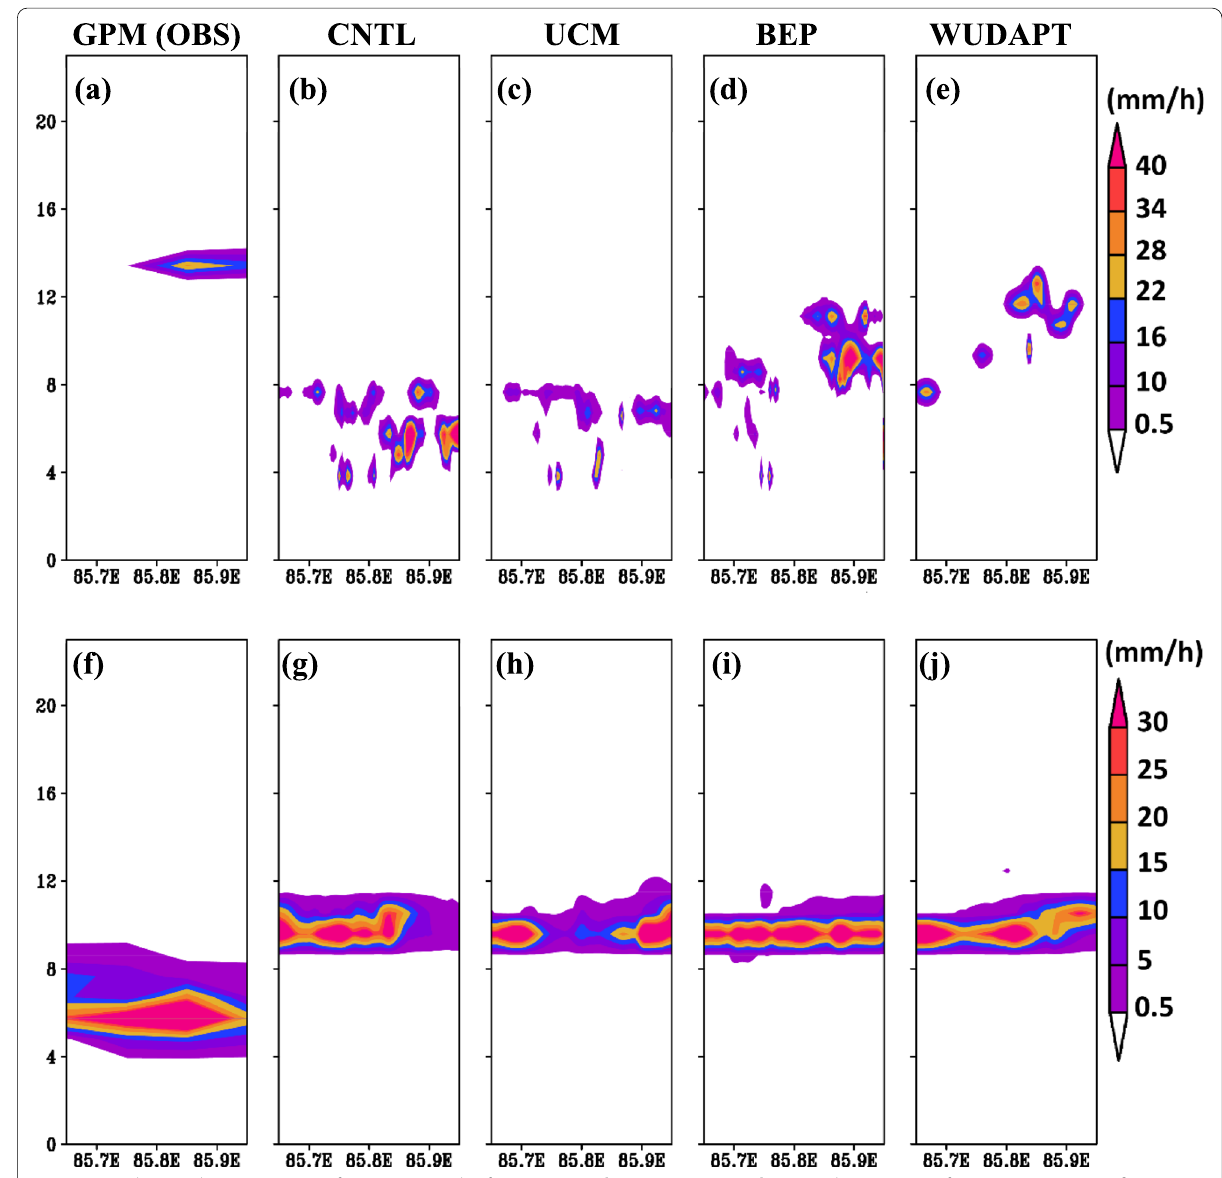
Fig. 5 Time-longitude cross section of rain rate (mm/hr) from ( a ) GPM, ( b ) CNTL, ( c ) UCM, ( d ) BEP, and ( e ) WUDAPT for 30 May 2017 case. f - j are same as ( a - e ) but for 14 May 2018 case. X-axis represents the longitude and Y-axis represents the